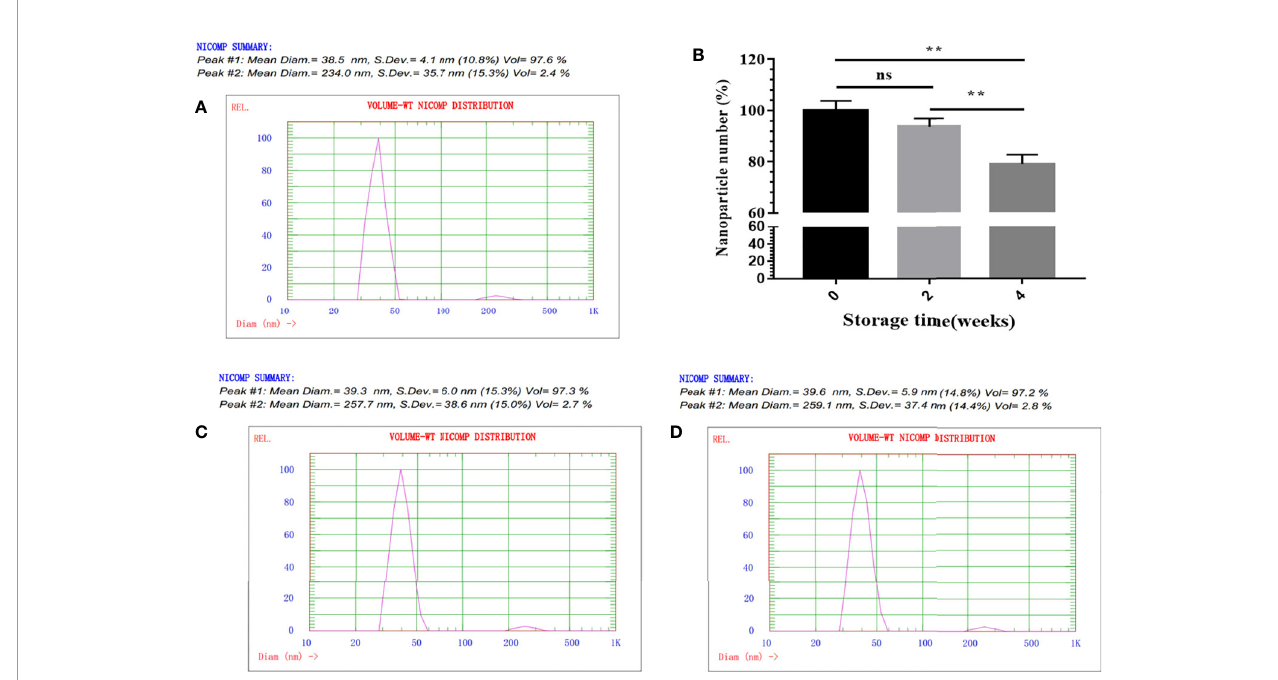
FIGURE 2 | physicochemical characterization of SP-E2-mi3 NPs. (A) Hydrodynamic diameter and size distribution of mi3 NPs was analyzed by DLS. (B) Storage stability analysis of SP-E2-mi3 NPs. SP-E2-mi3 NPs was stored at room temperature for 0, 2 and 4 weeks, and then subject to NPs imaging by TEM. NPs counting were calculated by ImageJ. DLS was then performed to show size distribution of SP-E2-mi3 NPs stored for 2 (C) and 4 weeks (D) . All analyses were performed in triplicate. (**p < 0.01; ns, not signi fi cant, p >